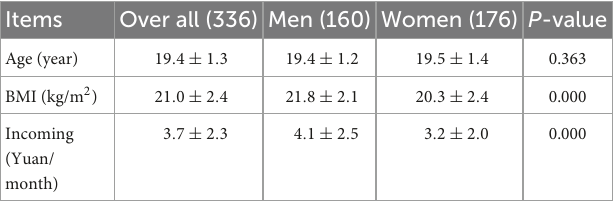
TABLE 1 Basic information of participants (M ± SD).